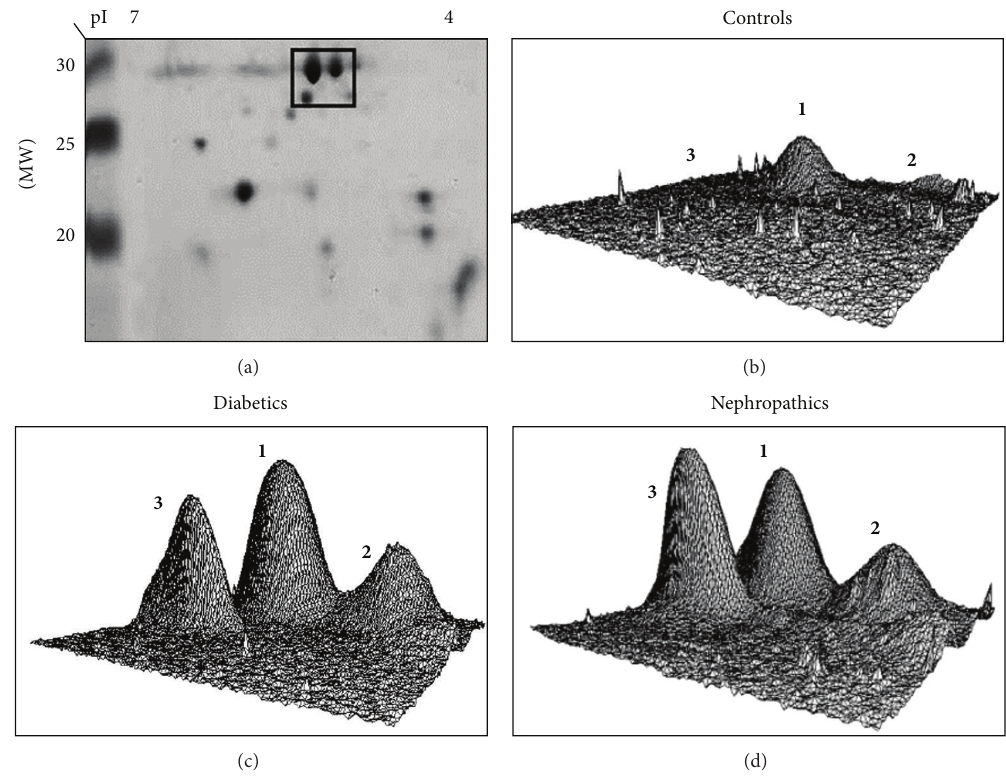
Figure 9: (a) 2D and 3D plots of 2-DE protein spots 1 , 2 , and 3 (Apo A-1, glycated Apo A-1, and RBP, resp.) of (b) control, (c) diabetic, and (d) nephropathic subjects. From [30], by kind permission of Wiley and Sons through RightsLink, License no. 3064270990822.